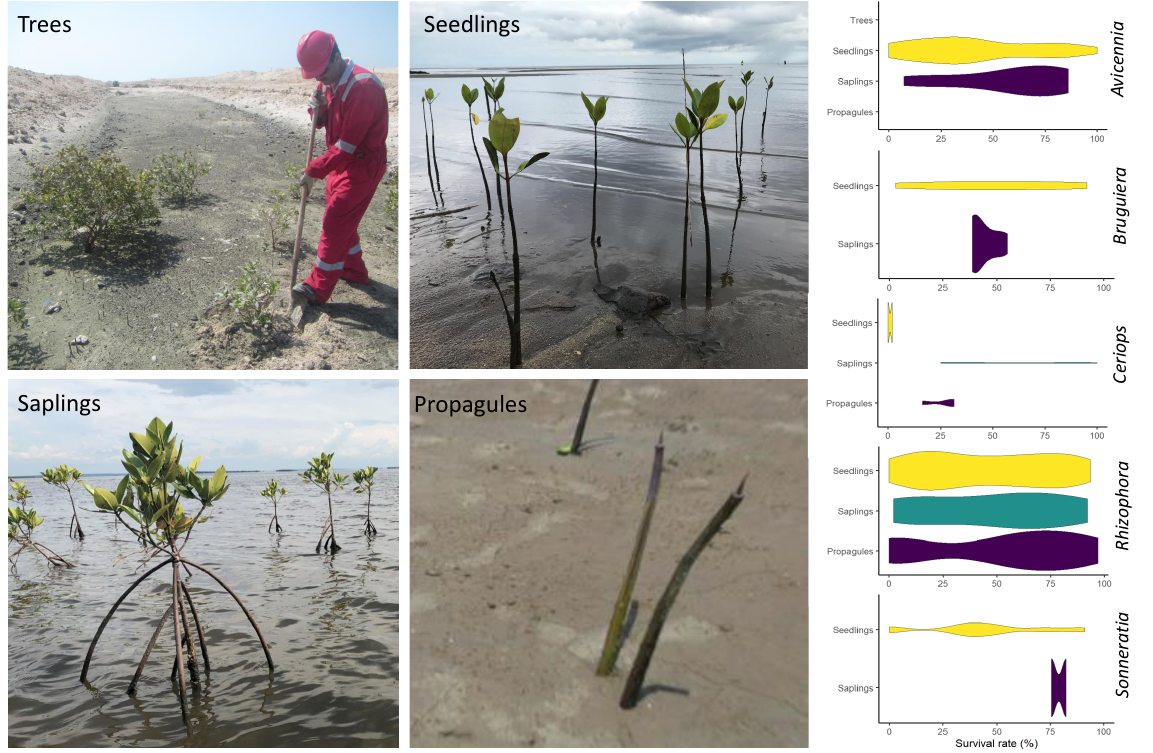
Figure 2. Violin plot showing the distribution of survival outcomes (%) for mangrove planting projects using different life history stages, for each of the 5 main genera used. Photos by D.G., M.V. and Dr. Paul